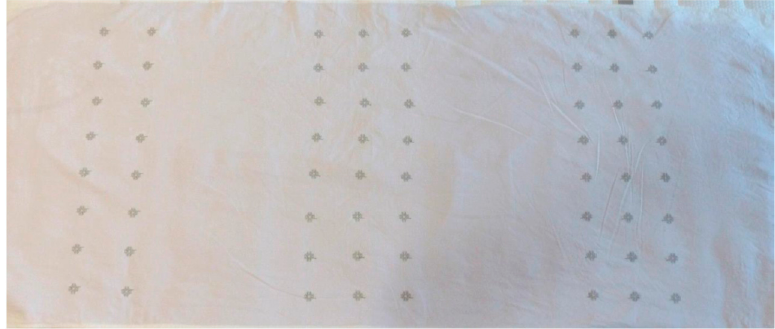
Figure 9. The development of a program for the sensors’ incorporation with Digitizer MB.